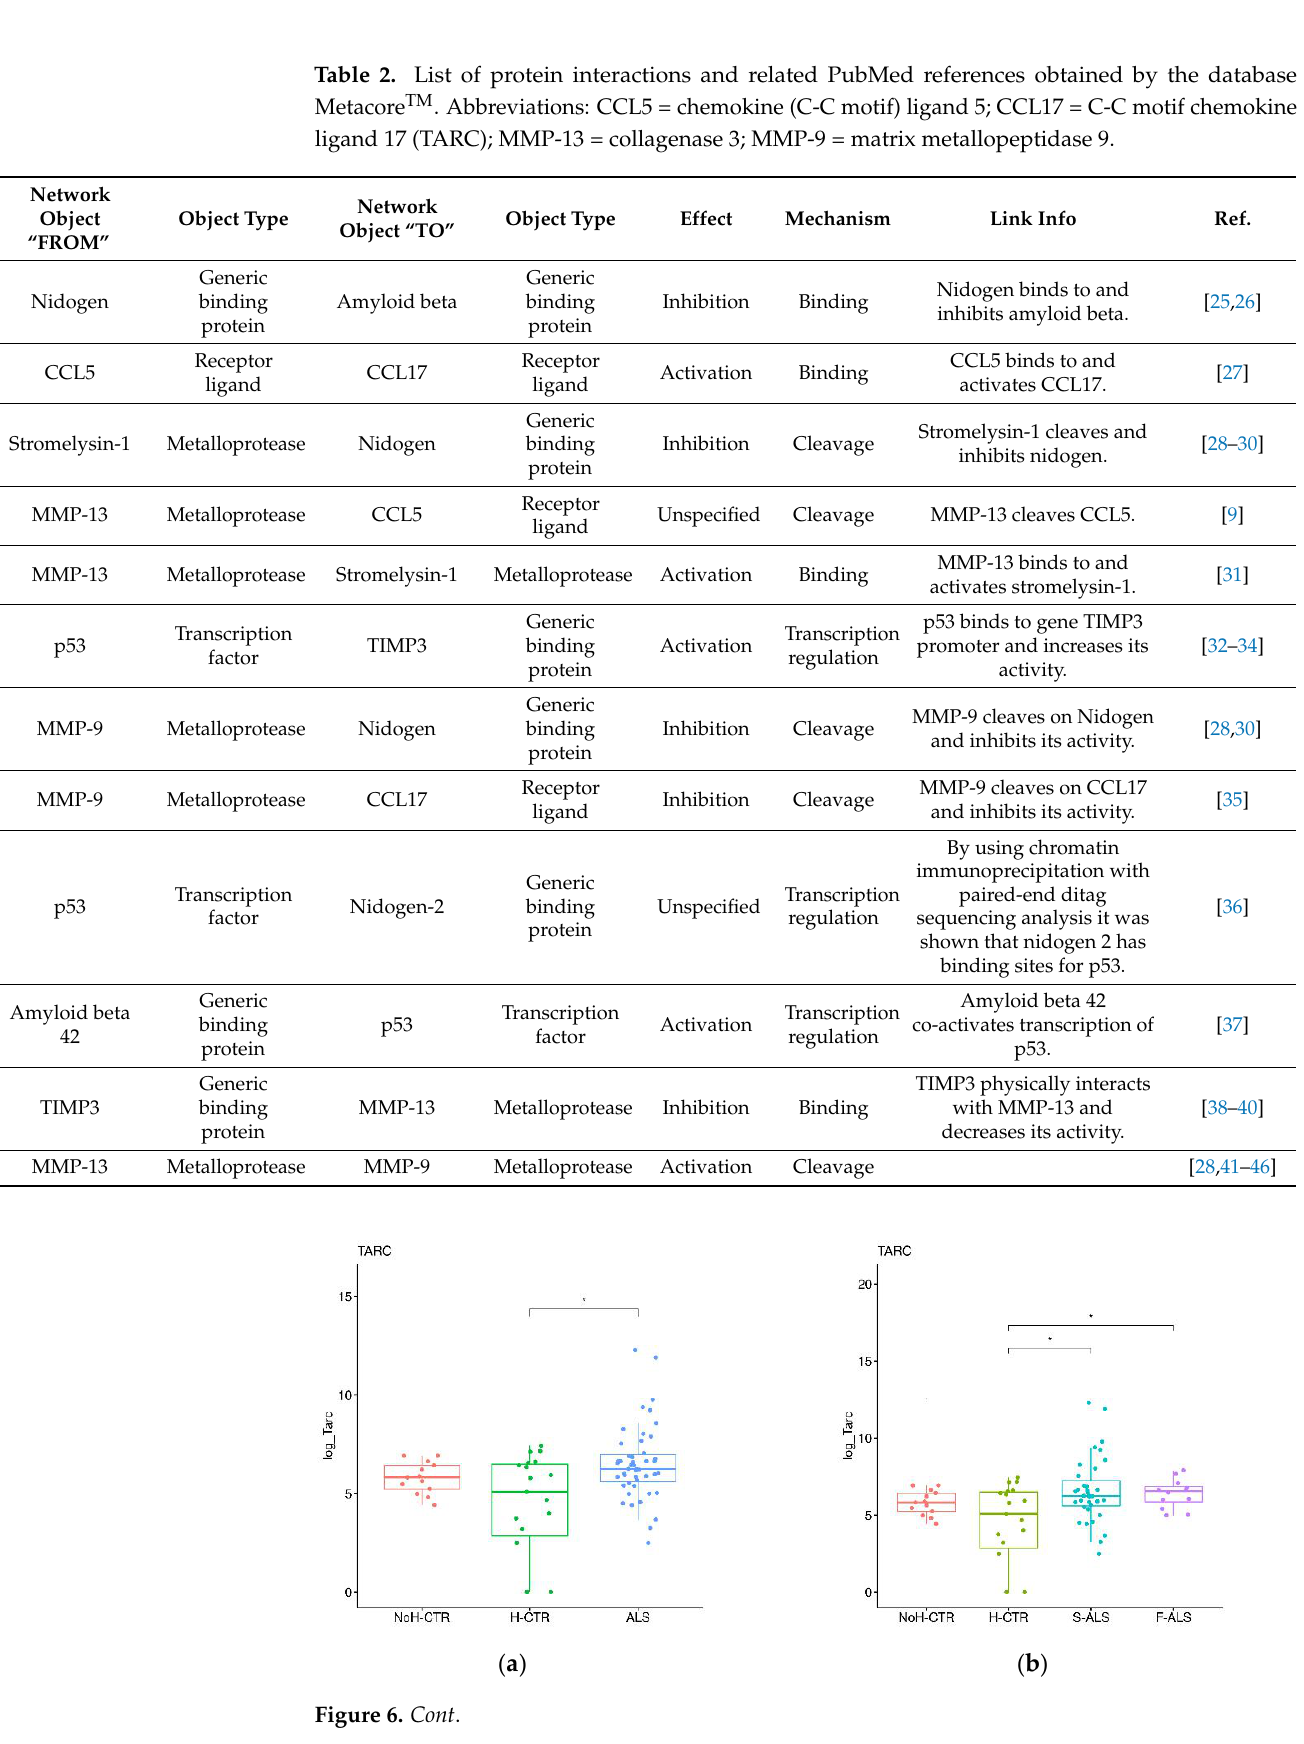
Table 2. List of protein interactions and related PubMed references obtained by the database